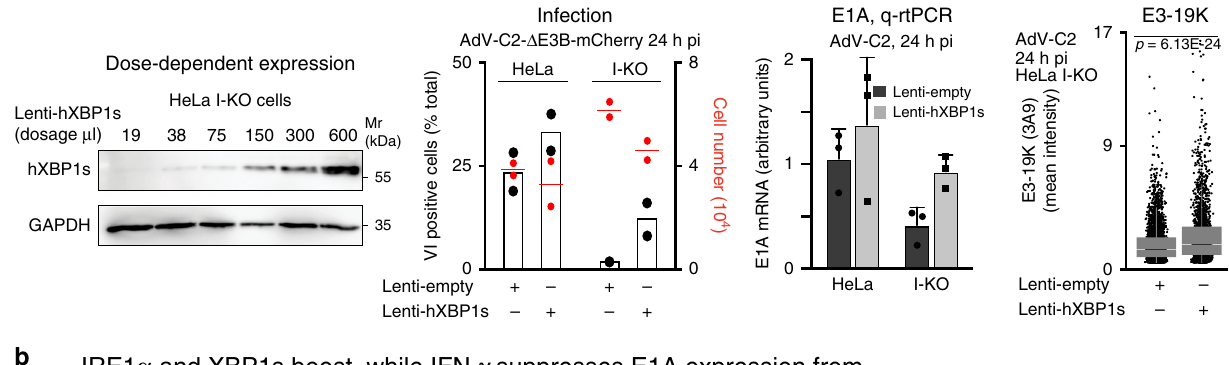
b IRE1 α and XBP1s boost, while IFN- γ suppresses E1A expression from